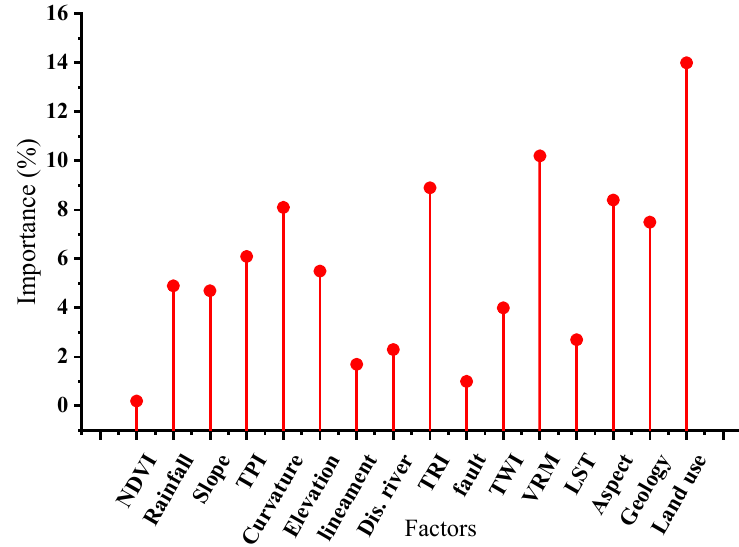
Figure 4. Variable importance analysis. Karst groundwater potential was split into five classes (very low, low, moderate, high, and very high) using the natural break algorithm in ArcGIS 10.5 and then mapped (Figure 5).